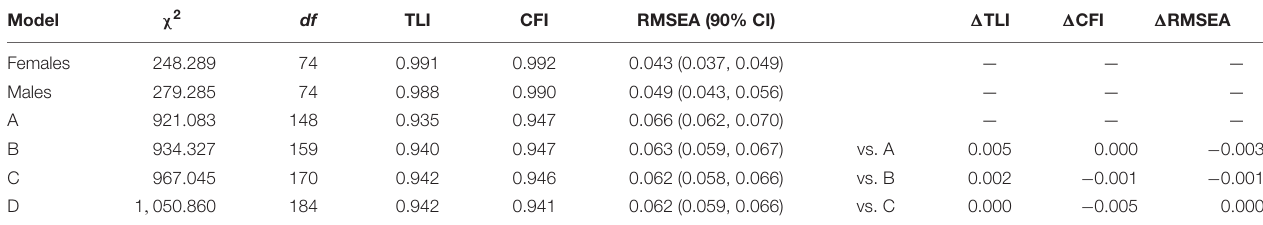
TABLE 5 | Goodness-of-fit indices and model comparisons for measurement invariance models.